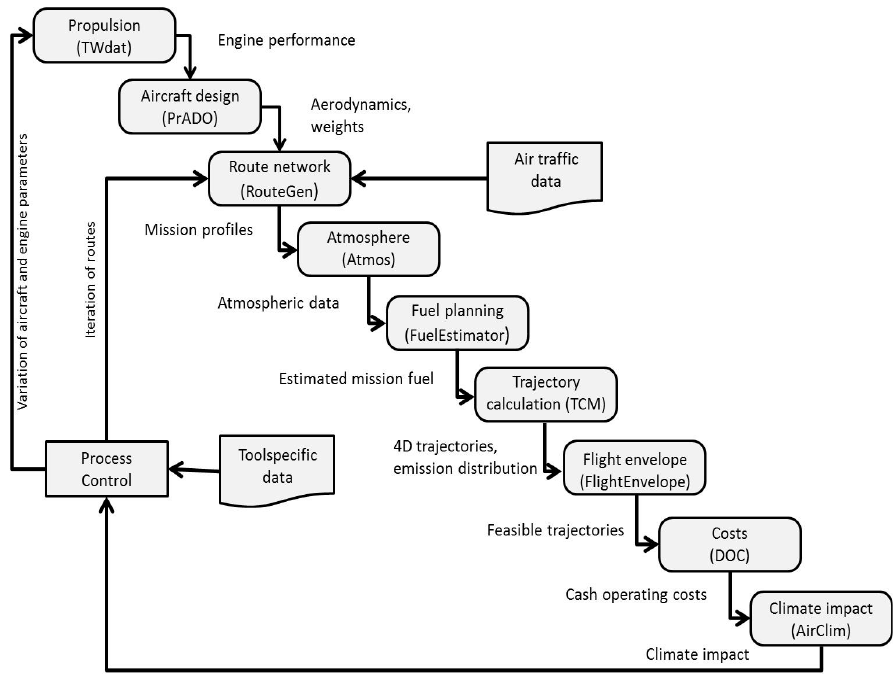
Figure 2. Climate-compatible Air Transport System (CATS) simulation workflow with integrated models and iteration paths for varying routes and/or aircraft design changes. Adapted from Koch et al.